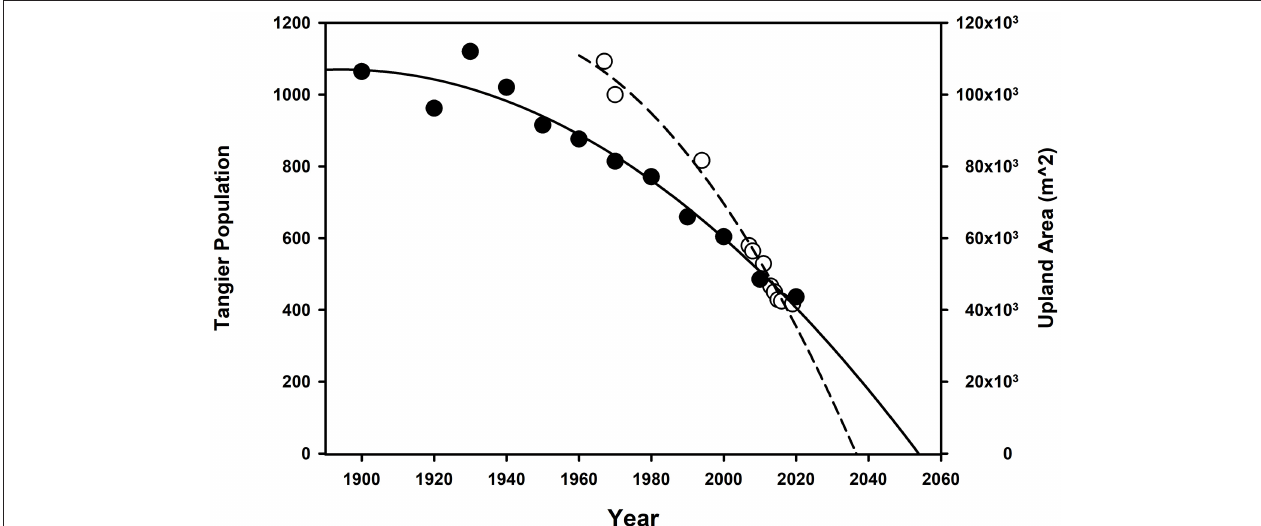
FIGURE 6 | Regression of both the population decline and the overall rate of wetland conversion of all three ridges combined for the Town of Tangier. The filled circles and the solid line represents the population decline. The open circle and the dashed line represent the overall wetland conversion rate. Population decline regression: ( y = − 1,49,913.413 – 0.042x 2 + 159.404x ), ( r 2 = 0.96 and p < 0.05 for all parameters). Overall wetland conversion rate regression: ( y = − 12,72,18,187.167 – 34.086x 2 + 1,31,885.035x ), ( r 2 = 0.99 and p <